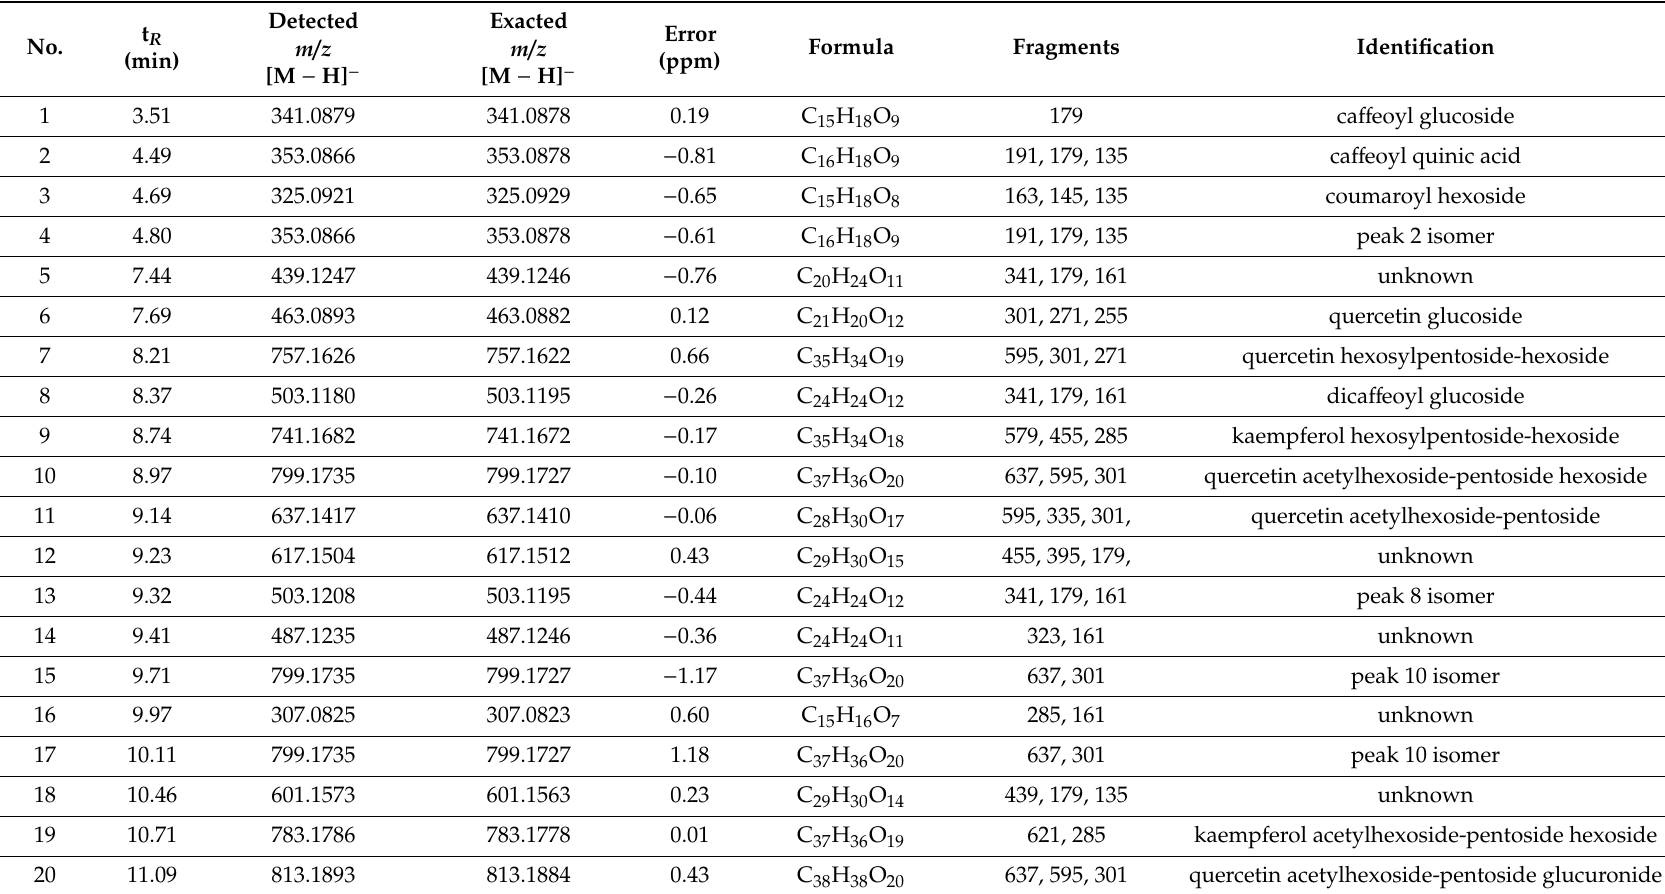
Table 1. Tentatively identification of major peaks detected in Spiraea prunifolia var.